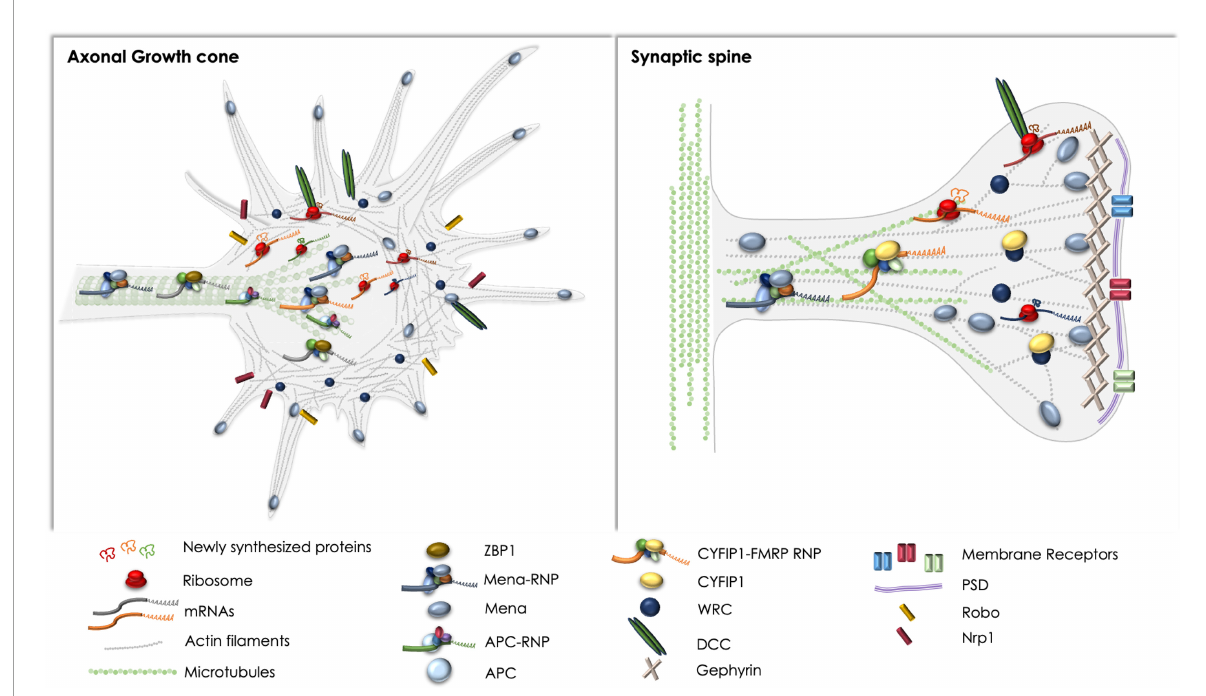
FIGURE1 Schematic representation of the complexes discussed herein, with respect to basic components and spatial distribution in axonal growth cones (left) and synaptic spines (right). Note the regulatory complexes that have been reported and could potentially affect local protein synthesis and cytoskeletal rearrangements in both compartments, like the DCC receptor and the Mena-RNP. ZBP1 and the APC-RNP have been extensively studied in axons, whereas the CYFIP1-FMRP-RNP has been primarily examined in synapses. Potential crosstalk between the pathways remains elusive, although the direct or indirect association of receptors like DCC and Robo with Mena, or the WRC has been previously reported (Menzies et al., 2004; McConnell et al., 2016; Zou et al.,